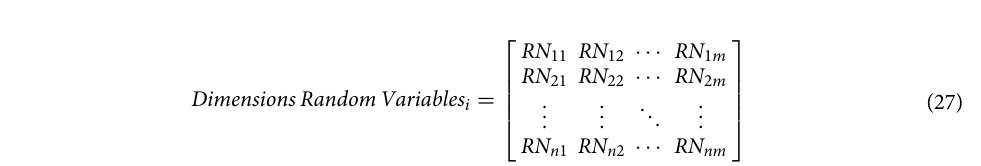
Figure 10. Demonstrating the dimension boundaries